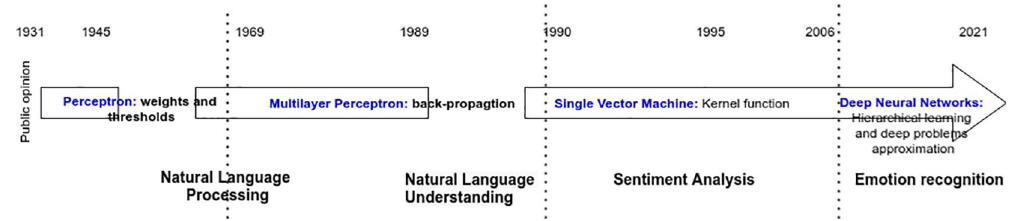
Fig 8. Brief chronology of SA following the development of